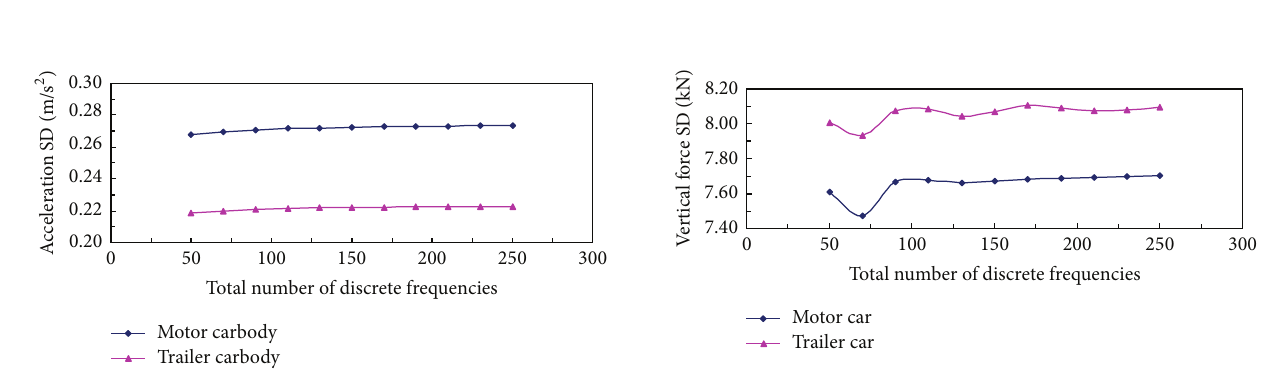
Figure 3: Maximum SD of vertical acceleration of carbody.